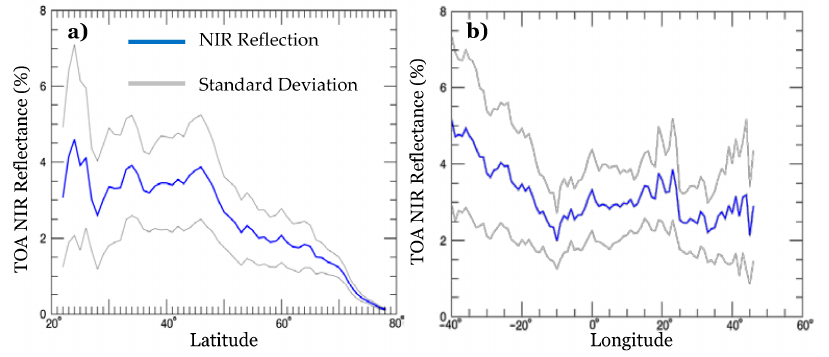
Figure 2. Mean NIR reflection over cloud-free water bodies for February 2009 ( a ); and April 2009 ( b ) integrated per degree latitude ( a ); and longitude ( b ).